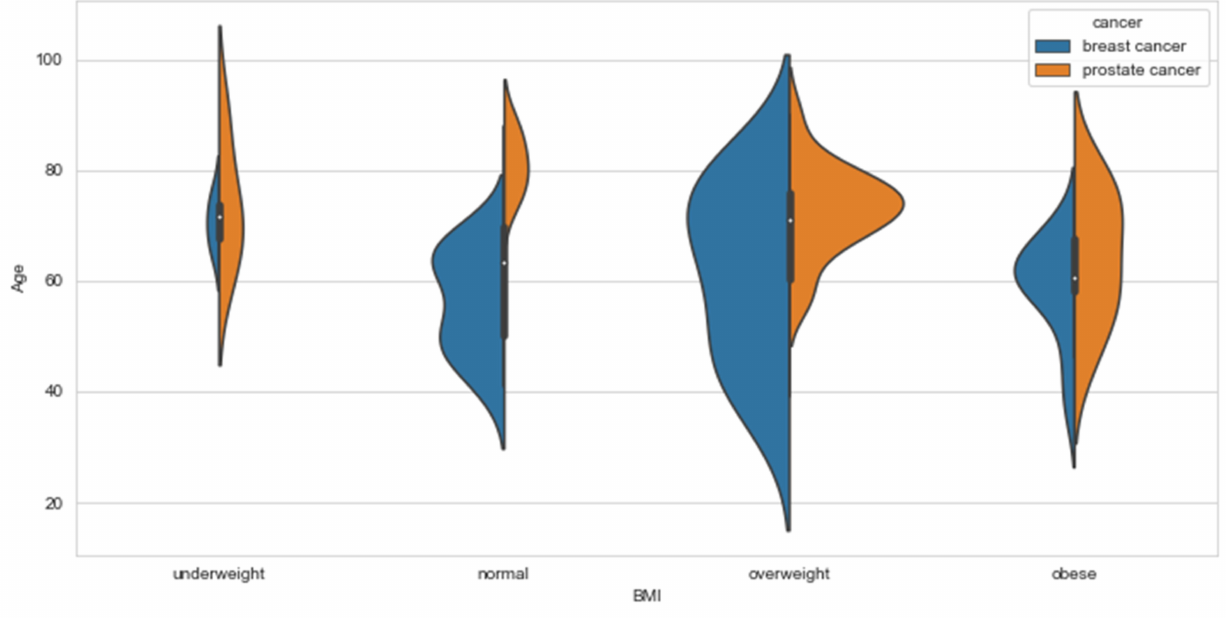
Figure 5. Population graphs for BCa and PCa BMI for metastatic and non-metastatic